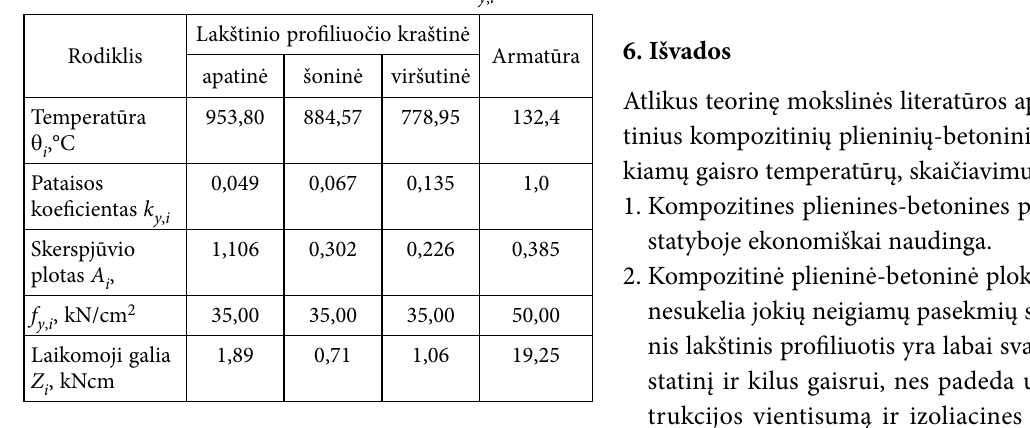
Table 10. Calculation with coefficient k